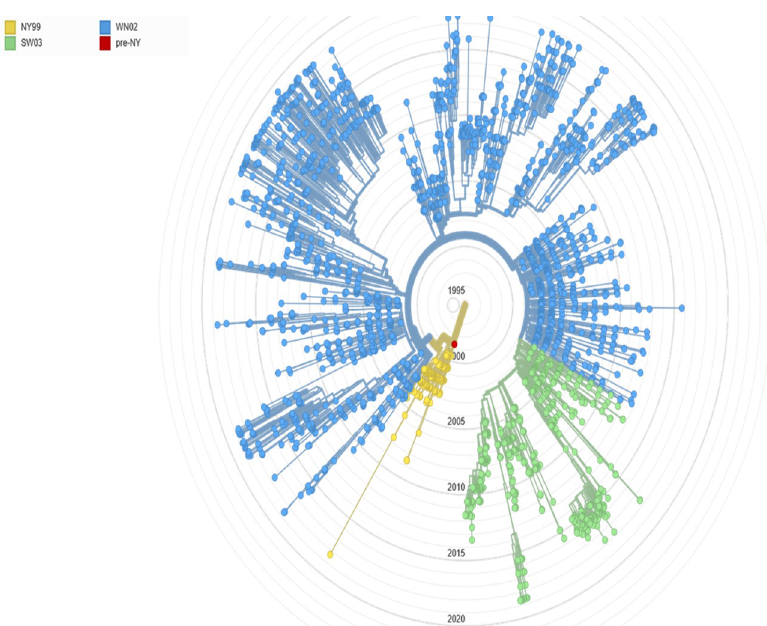
Fig 2. WNV strains over time. This image was reproduced with permission from N . Grubaugh from the data available at https : //nextstrain . org/WNV/NA [21,45]. WNV, West Nile virus.